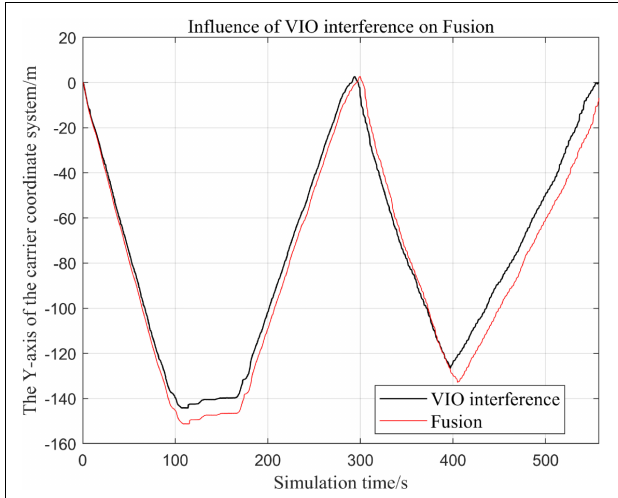
FIGURE 17 | Comparison of the overall trajectory in y -axis after VIO failure and when the sensor is working normally.